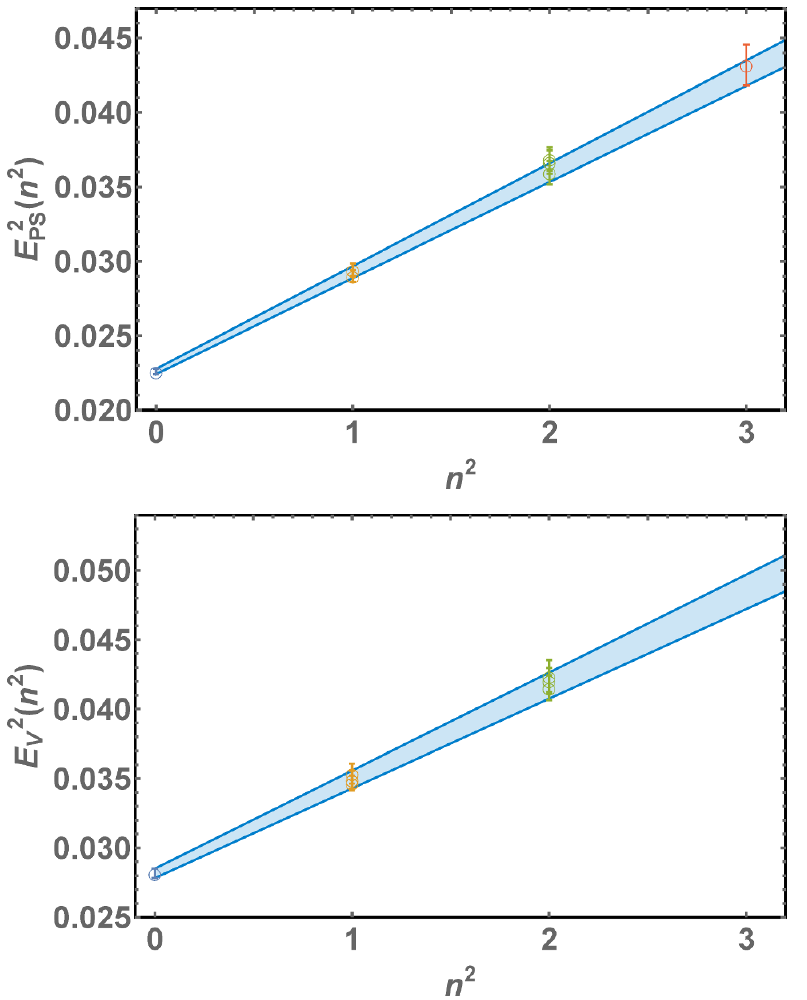
Figure 5 . Squared energy as a function of squared momentum j ~n j 2 for a pseudoscalar meson E 2 and a vector meson E 2 . The blue band is obtained by (cid:12)tting data over n 2 = [0 ; 1] to a linear V function of eq. (3.11). The lattice bare parameters used in these plots are (cid:12) = 2 : 0, m 0 = (cid:0) 0 : 2, (cid:24) 0 = 4 : 7, (cid:24) 0 = 4 : 7, and N t (cid:2) N 3 = 128 (cid:2) 12 3 g s f